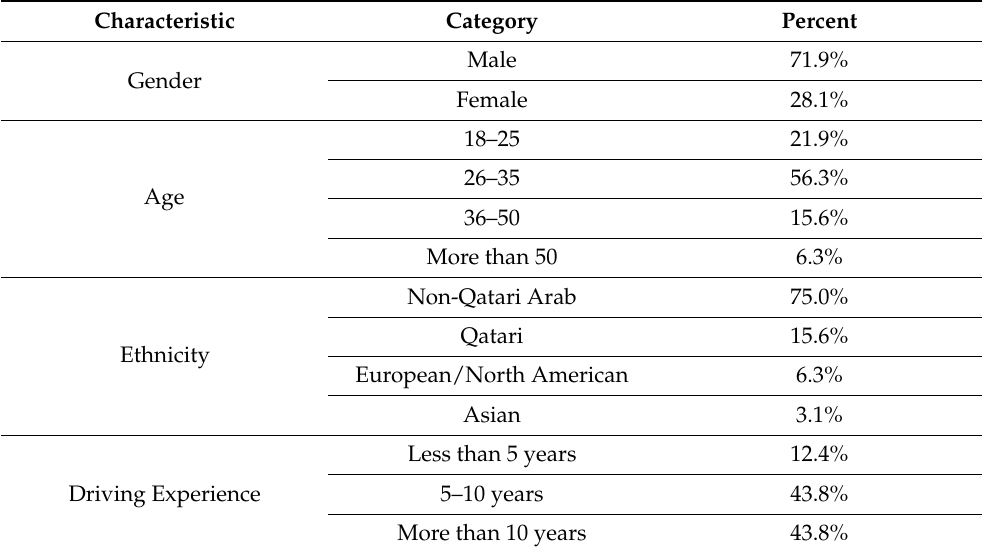
Table 1. Participants’